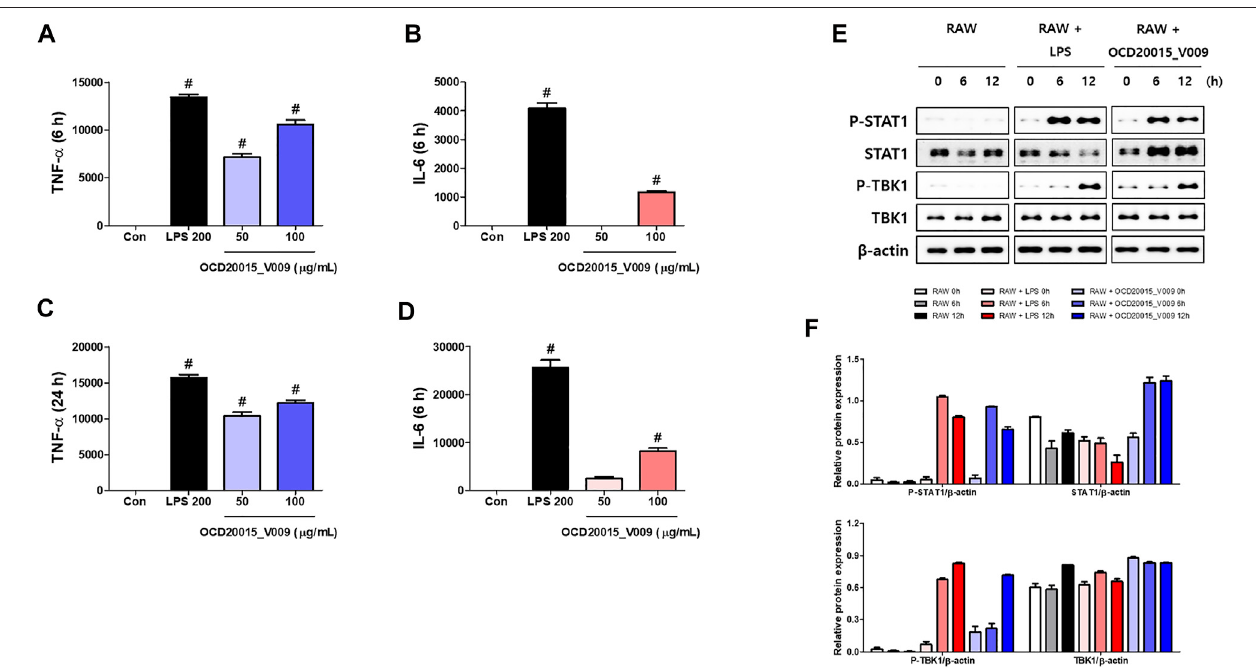
FIGURE 3 | The activation of type-I interferon (IFN) and induction of pro-in fl ammatory cytokines by OCD20015-V009 in RAW 264.7 cells. (A – D) The cells were treatedwithvehicle alone,200 ng/mlLPS,or50and 100 μ g/ml OCD20015-V009and incubated at37 ° C.Thesupernatant fromeach treatment groupwasharvestedat 6 or 24 hand centrifuged at 15,000 gfor 10 min at 4 ° C. The clari fi edsupernatants weredispensed intothe enzyme-linked immunosorbent assayplatescoated with the captured antibody of murine interleukin (IL)-6 or tumor necrosis factor (TNF)- α to measure cytokine secretion. The experiment was performed in triplicate. (E,F) Western blotting of whole-cell lysates of macrophages treated with vehicle alone, 200 ng/ml LPS, or 200 μ g/ml OCD20015-V009 was performed to assess the level of the non-phosphorylated and phosphorylated forms of TANK-binding kinase 1 (TBK1), STAT1, and β -actin over time. ** p < 0.01 and *** p < 0.001 indicate a signi fi cant difference between control